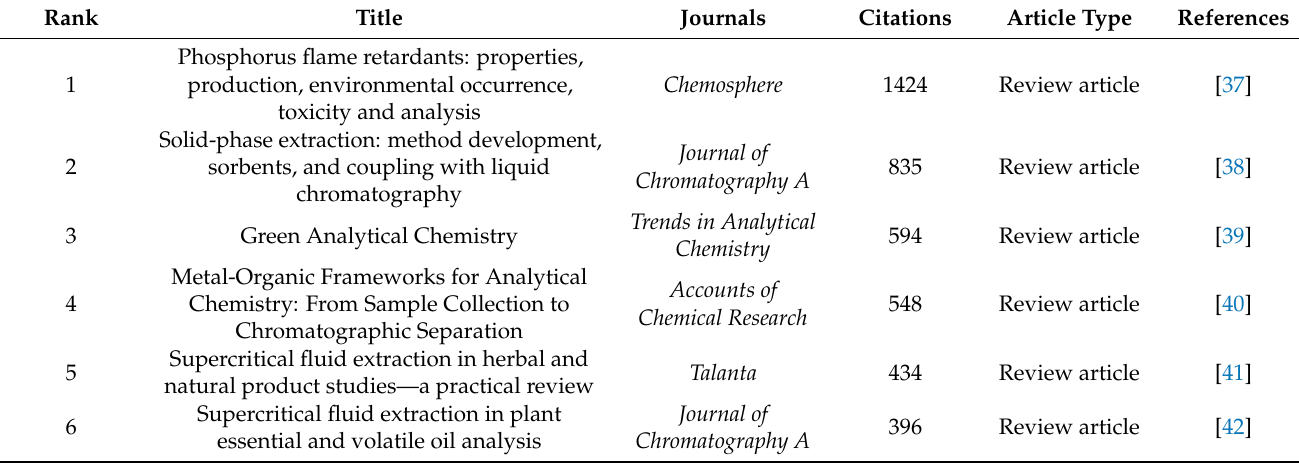
Table 2. Top 10 articles ranked by number of